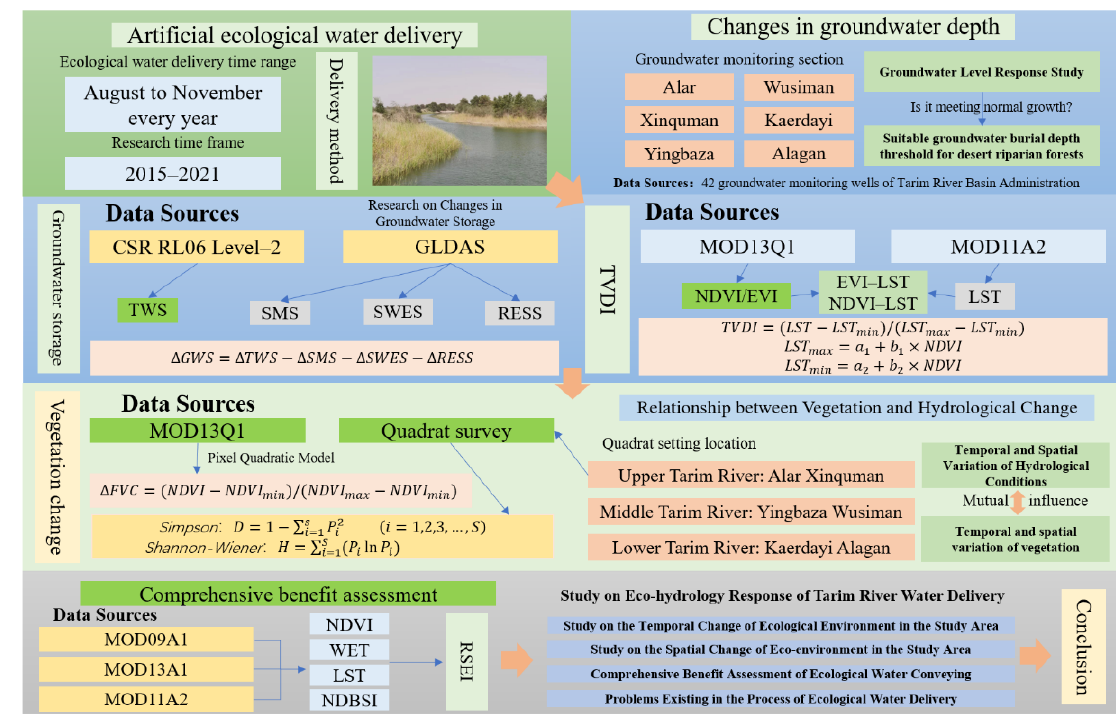
Figure 2. Technical roadmap.